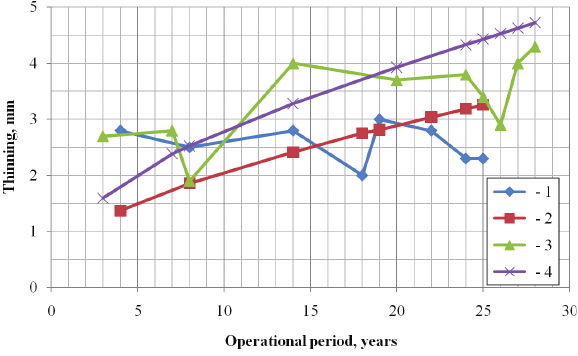
Figure 4. Control data and forecast results for the steam line: 1 – protocol (SL); 2 – forecast (SL); 3 – protocol (FL); 4 – fore- cast